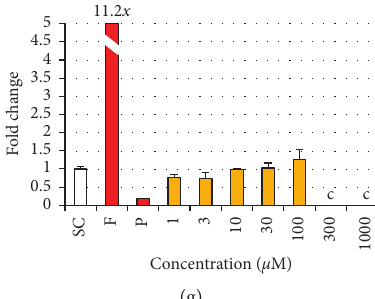
Figure 8: Estradiol production in H295R cells exposed to phthalates and substitutes. H295R cells were exposed for 48h to different concentrations of each phthalate and substitute, solvent control (SC), and forskolin 10 μ M(F) and prochloraz 1 μ M(P) as reference inducer and inhibitor of steroidogenesis. (c) Cytotoxic concentration (viability < 80%) is not analyzed. Results represent the mean fold change in hormone concentration compared to SC ( � 1) ± SD of 3 replicates from one representative assay out of 2 assays. ∗ p < 0.05, ∗ ∗ p < 0 . 01. (a) DEHP. (b) DINP. (c) DEHT. (d) DINCH. (e) TOTM. (f) POLYSORB ® isosorbide. (g) POLYSORB ® ID 46.